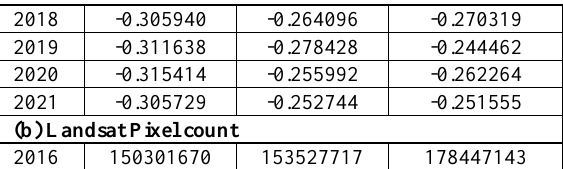
Table 3. (a) Otsu Threshold value for Landsat images of Ganga